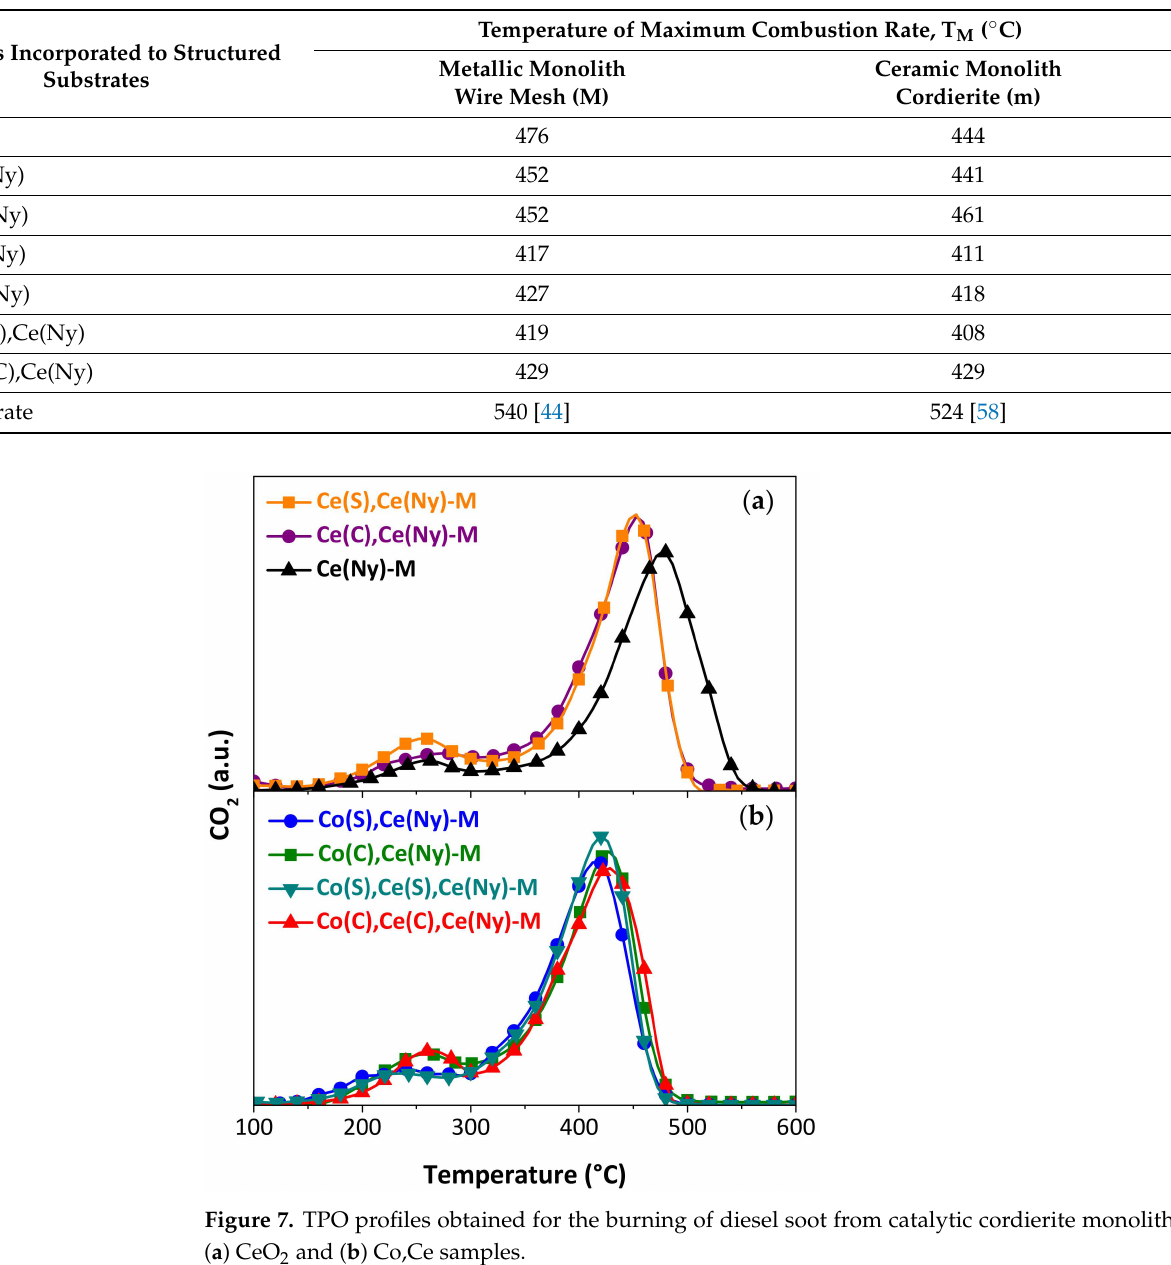
Table 3. The catalytic activity of structured substrates for soot combustion (from Figures 7 and 8).